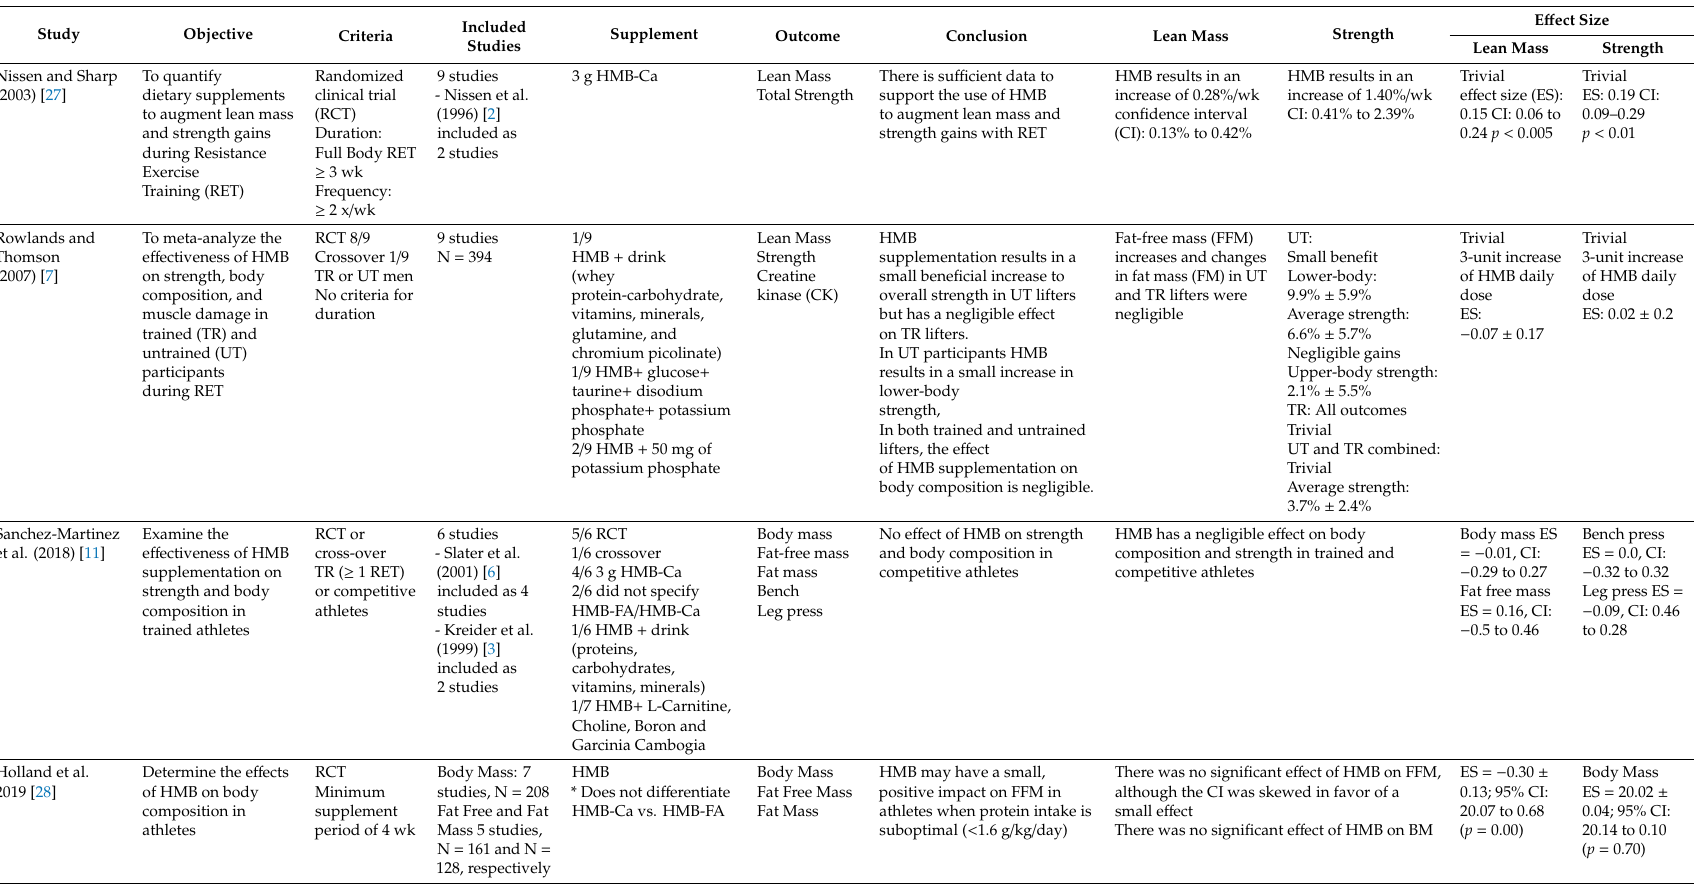
Table 1. Main findings of previous meta-analyses assessing e ff ects of β -hydroxy- β -methylbutyrate (HMB) ingestion in lean body mass and strength gains in subjects submitted to a resistance exercise